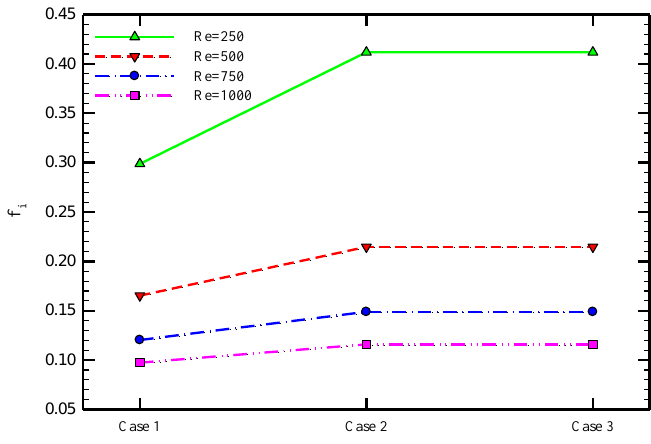
Figure 8. Variations of friction coe ffi cient for di ff erent cases of PHE, Co-STT, and Counter-STT at various Reynolds numbers.